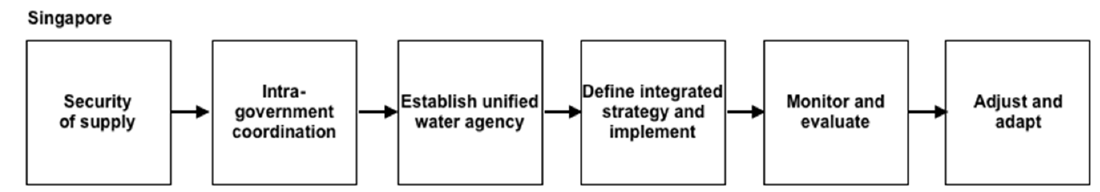
Figure 3. Process tracing adoption of IUWM in Singapore.